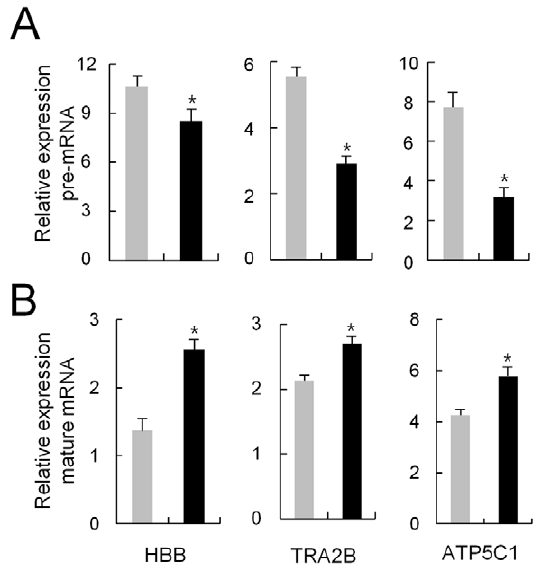
Figure 5. Pre-mRNA levels in D LF-overexpressing cells. Real-time RT-PCR was carried out to measure the pre-mRNA (A) and mature- mRNA levels (B) of the three selected genes. Primers spanning an exon and its downstream intron were used for pre-mRNA and primers spanning two exons were used for mature-mRNA. Gray and black bars denote the expression of the indicated genes for non-treated and treated with tetracycline in the D LF cells, respectively. Each clone was analyzed in duplicate, and the average relative expression level of 15 clones is presented with the standard error. *Significant (P , 0.05; Student’s t -test).